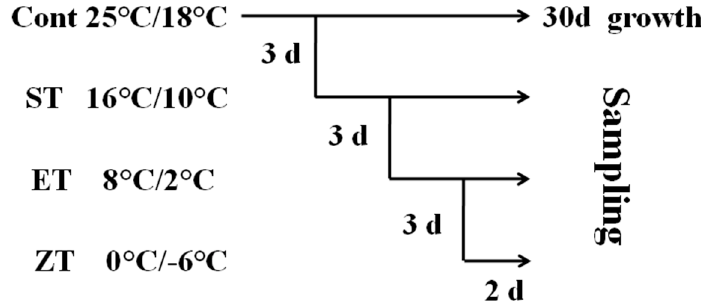
Figure 2. A schematic diagram of the low temperature treatment.